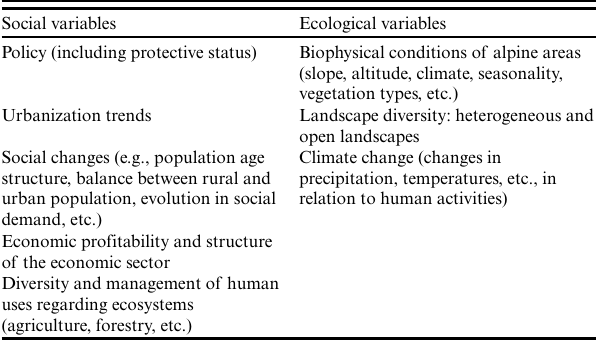
Table 2 . Social and ecological variables mentioned by interviewees to describe influence relationships with ecosystem services (ES) and biodiversity in the alpine social-ecological